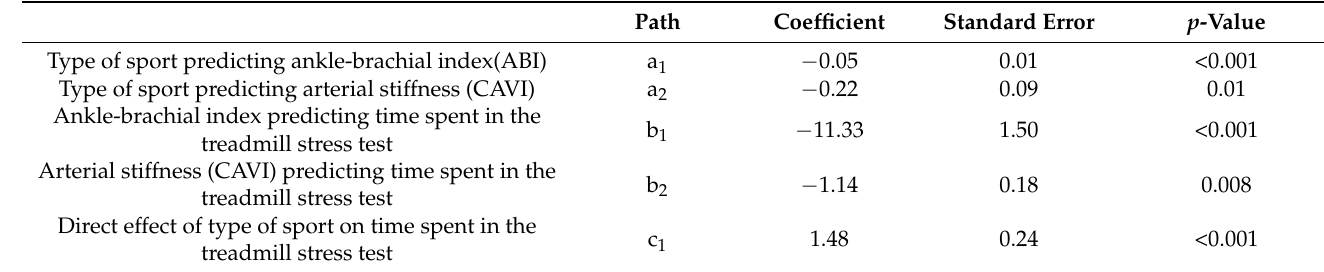
Figure 3. Variation of cardiovascular markers during the treadmill stress test according to the ankle- brachial index. Blank boxes represent subjects with normal values (ABI 1.0–1.2), dashed subjects with acceptable values (ABI 0.9–1.0), and lastly, black box arterial disease (ABI < 0.9). T0 was the warm-up; TL was the last step reached during the test. ( A ) Systolic blood pressure (mm/Hg); ( B ) heart rate (bp/min); ( C ) rate pressure product (bp/min*mm/Hg). Table 2. Path coefficients of the model estimating the mediation effect of the ankle-brachial index (ABI) and arterial stiffness (CAVI) in the association between time spent in the treadmill stress test and type of sport